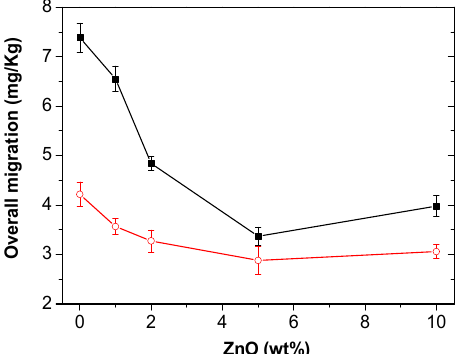
Figure 10. Overall migration data in ethanol 10% ( v / v ) (solid squares) and isooctane (open circles) for PHB and its